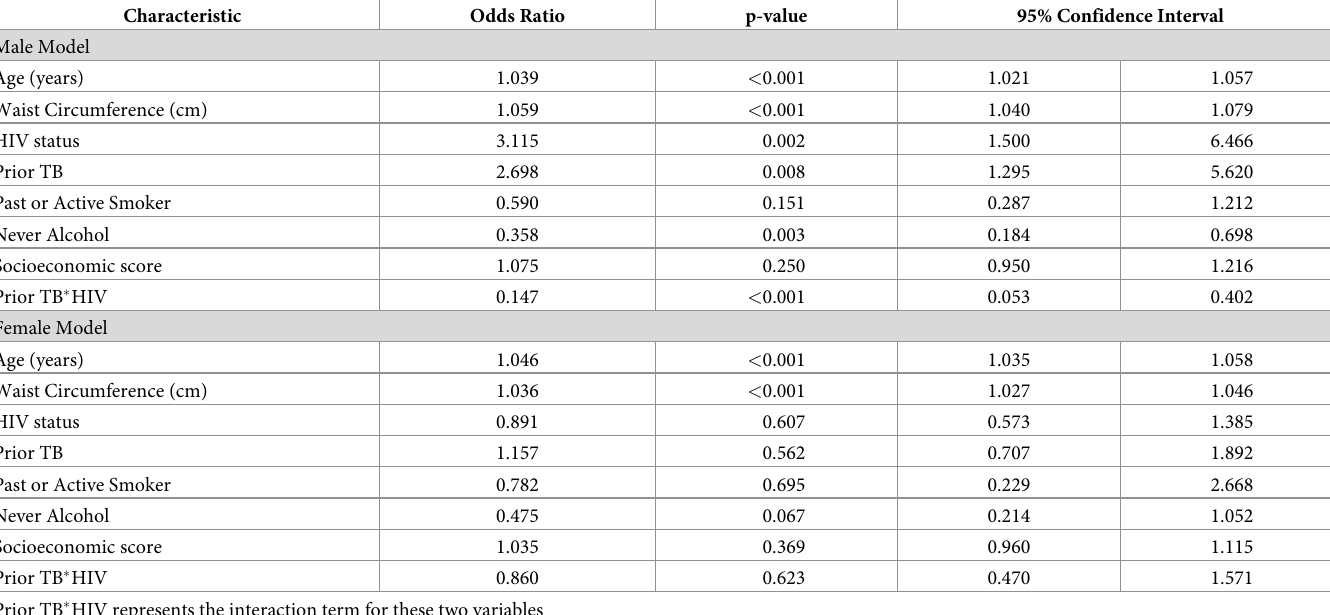
Table 2. Propensity score matched multivariate logistic regression models for dysglycemia.